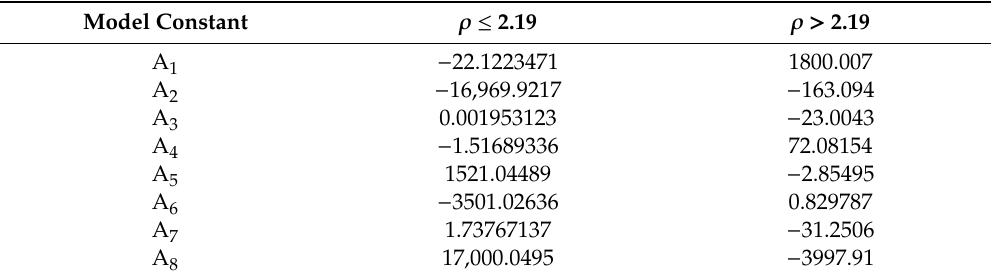
Table 2. Correlation constants of the new mathematical model for two di ff erent ranges of drilling mud density